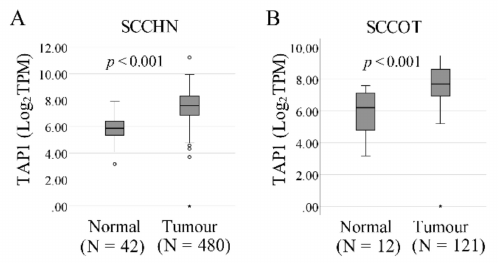
Figure 3. TCGA-HNSC (The Cancer Genome Atlas-head and neck squamous cell carcinoma) cohort data. Plots show TAP1 levels in tumors and tumor-free samples, the latter denominated “normal” in TCGA, for ( A ) the whole group of squamous cell carcinoma of the head and neck–SCCHN ( p < 0.001) and ( B ) for squamous cell carcinoma of the tongue (SCCOT) only ( p <